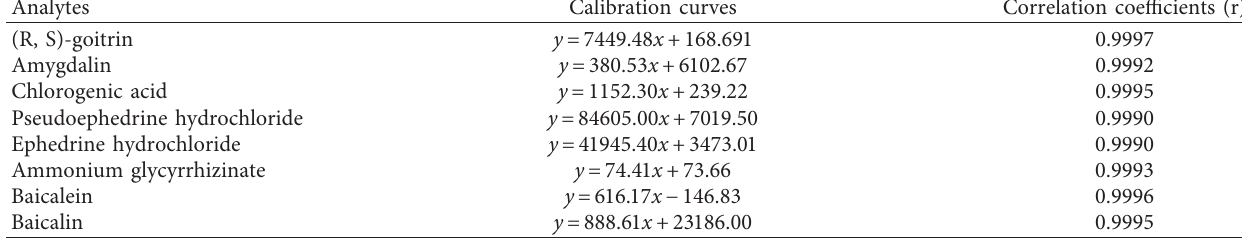
Table 1: Linear regression data of the eight analytes.